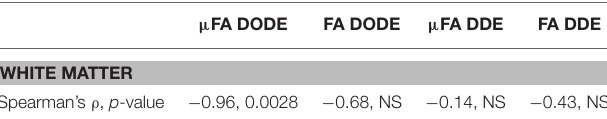
TABLE 3 | Statistical analysis of correlations between ( µ )FA and literature-based average axon diameter (extracted from Dula et al. [ 75]) in the rat spinal cord. µ FA DODE FA DODE µ FA DDE FA DDE WHITE